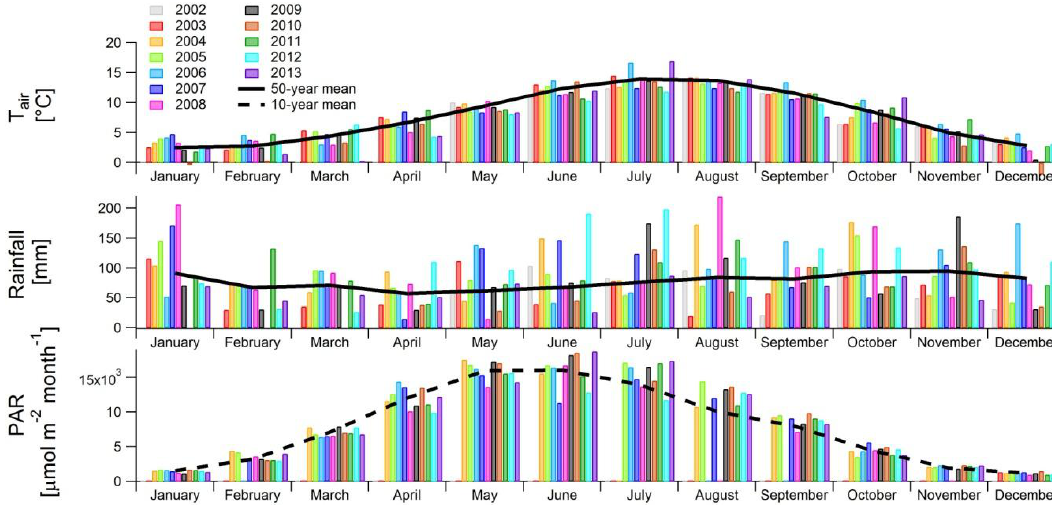
Figure 1. Monthly air temperature, rainfall and photosynthetically active radiation (PAR) for the study period 2002–2013.